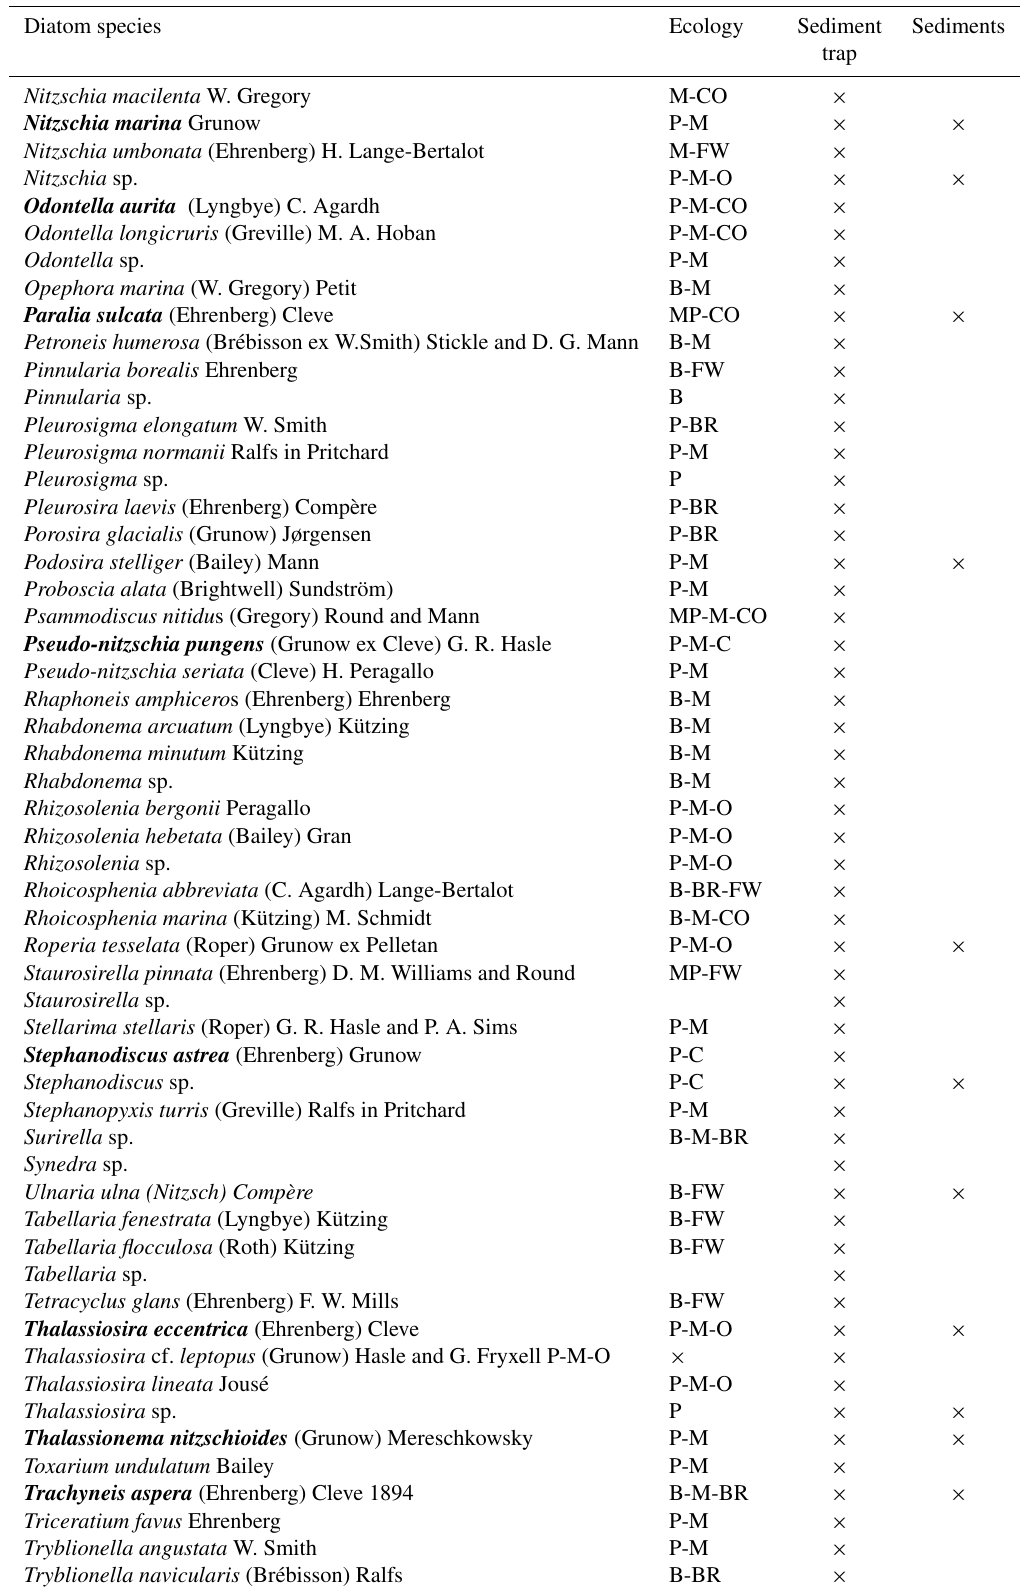
Tabellaria fenestrata (Lyngbye) Kützing Tabellaria flocculosa (Roth) Kützing × Tabellaria